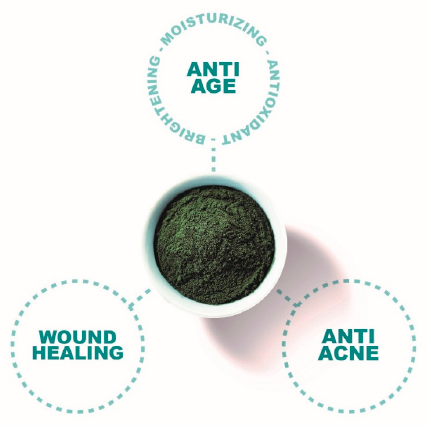
Figure 1. Current application of Spirulina in skin care. Table 2. Selection of recent studies about the skin care benefits of Spirulina herein discussed. Topic Study Object Outcome of the Study Year Reference Spirulina in dermocosmetic Benefits on hydration, skin barrier function and oil con- formulations trol. Antiaging effects. Spirulina fermented extracts Antiage— Moisturizing for skin care applications